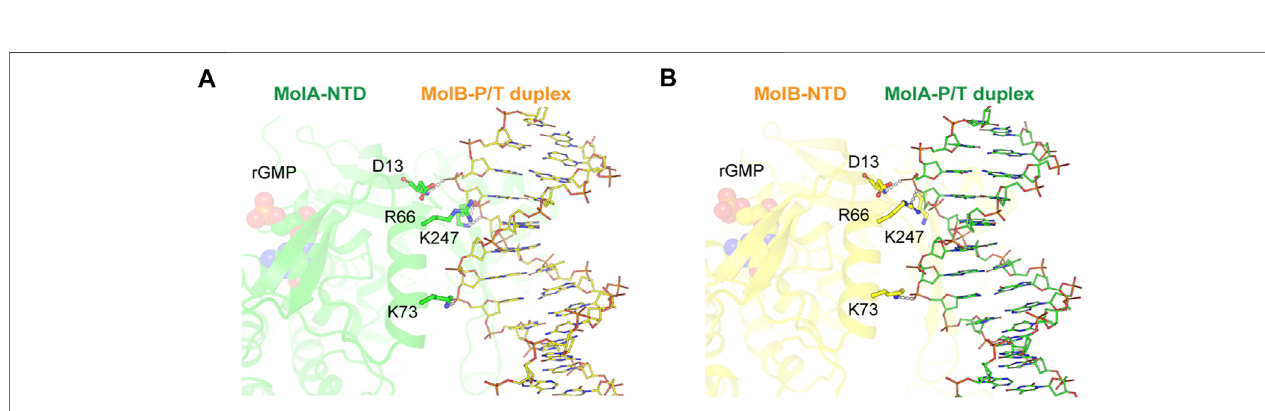
FIGURE5| Inter-complexinteractionbetweenternary(MolA,green)andbinary(MolB,yellow)complexes.DetailedviewsofinteractionsfortheNTD(MolA)withthe P/Tduplex(MolB) (A) andtheNTD(MolB)withtheP/Tduplex(MolA) (B) complexes.Nucleotides(rGMP)boundtotheN-terminaldomainandDNAhelicesareshownas spheresand sticks,respectively. HydrogenbondsbetweentheN-terminaldomain inonesubunitand theDNAstrand intheothersubunitaredisplayed asdashed lines.